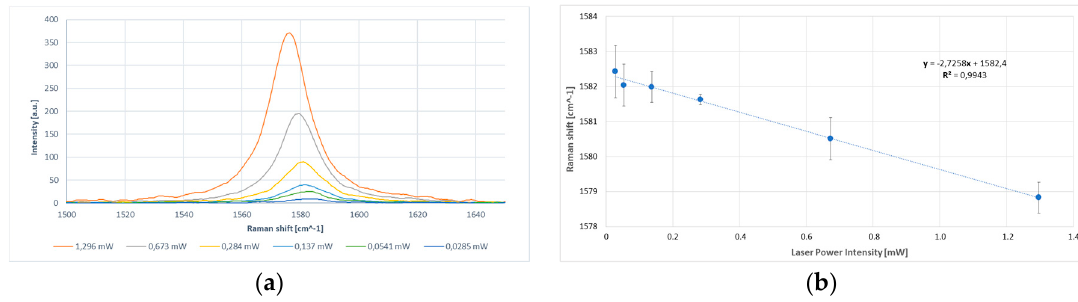
Figure 6. Phonons dependency with different laser power intensities. ( a ) The G peak region of the Raman spectrum from a single GnP recorded at six excitation power levels; and ( b ) the shift in G-peak spectral position due to change in total dissipated power. The spectra are excited at 532 nm and recorded at room temperature in the backscattering configuration.